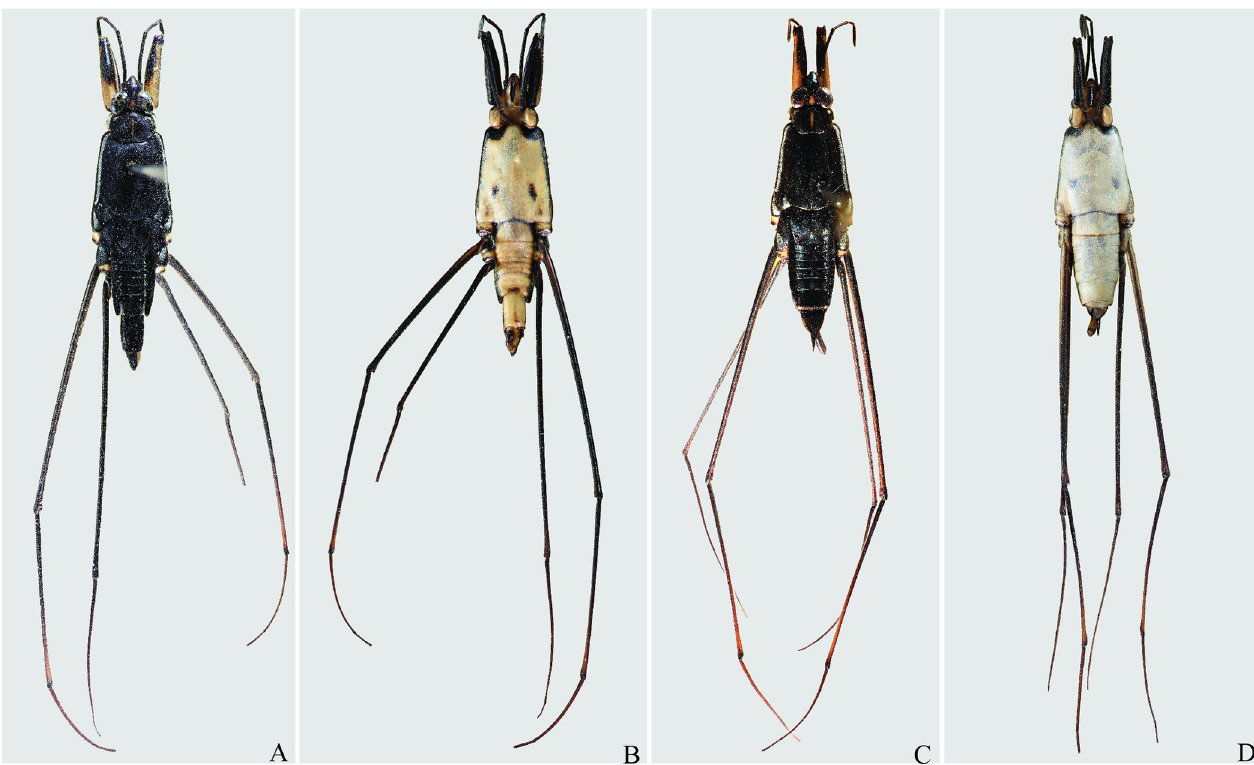
Fig 15. Potamobates bidentatus . (A) Male, dorsal view; (B) male, ventral view; (C) female, dorsal view; (D) female, ventral view. left basolateral process of male proctiger positioned above or beneath the projections of the left margin of segment VIII (Fig 1B), whereas the proctiger is dislocated to the left and the left basolateral process does not reach the projections of the left margin of segment VIII in P . tri- dentatus . This last characteristic must be used with caution, because the proctiger is mobile, which can affect the positioning of the left basolateral process in relation to the projections of segment VIII.